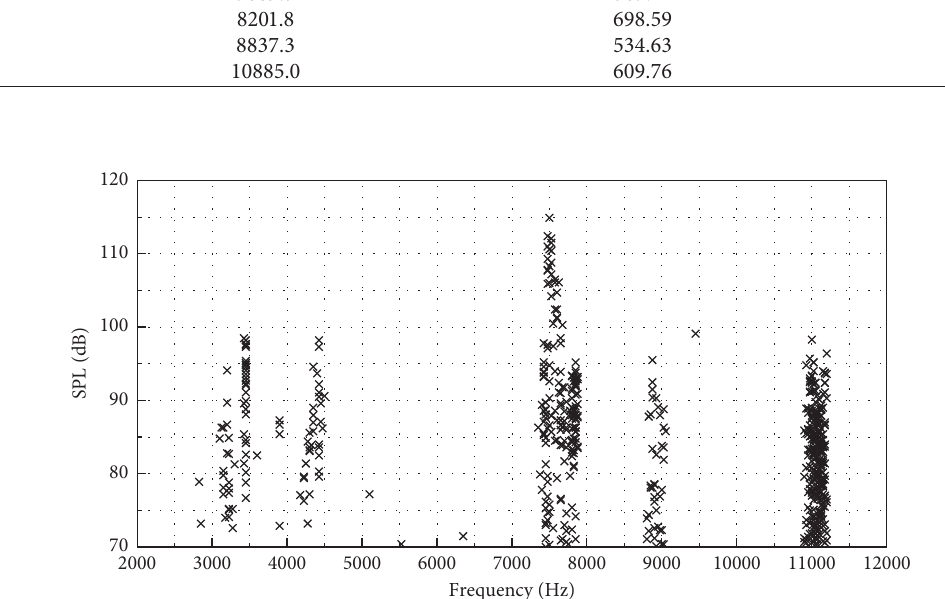
Figure 3: Noise distribution in the dynamometer